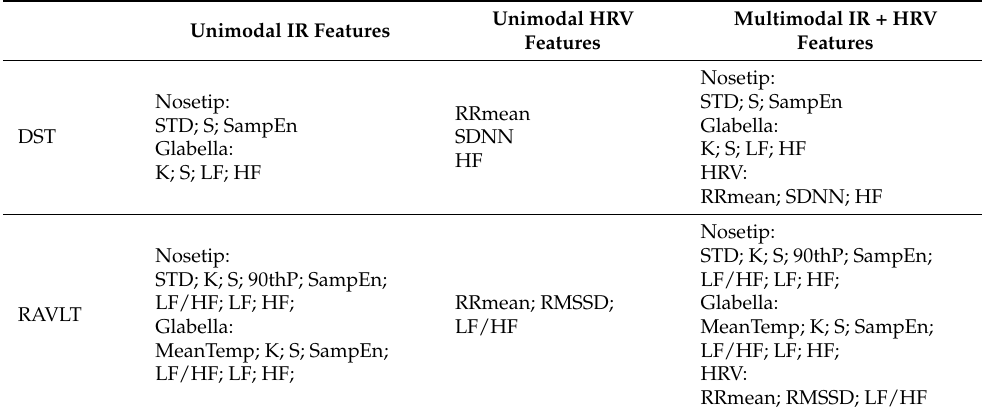
Table 3. Selected features after wrapping method for each of the developed